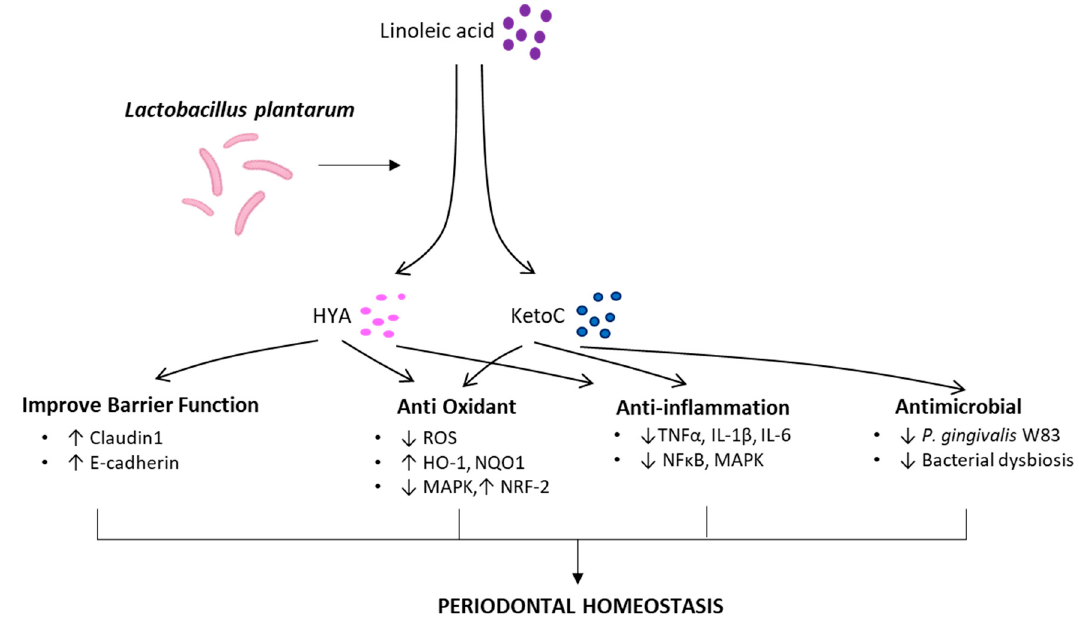
Figure 2. Beneficial functions of Lactobacillus -derived bioactive metabolites bring periodontal homeostasis. HYA and KetoC possess anti-oxidant [26,40], anti-inflammation [22,23,27,38,39,87], antimicrobial [21], and epithelial barrier junction improver [23,24].